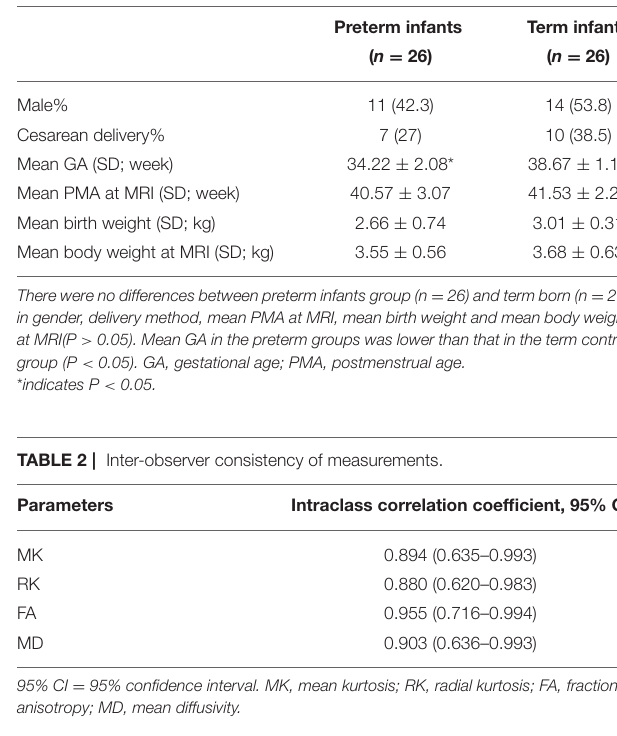
TABLE 1 | General demographics of infants.